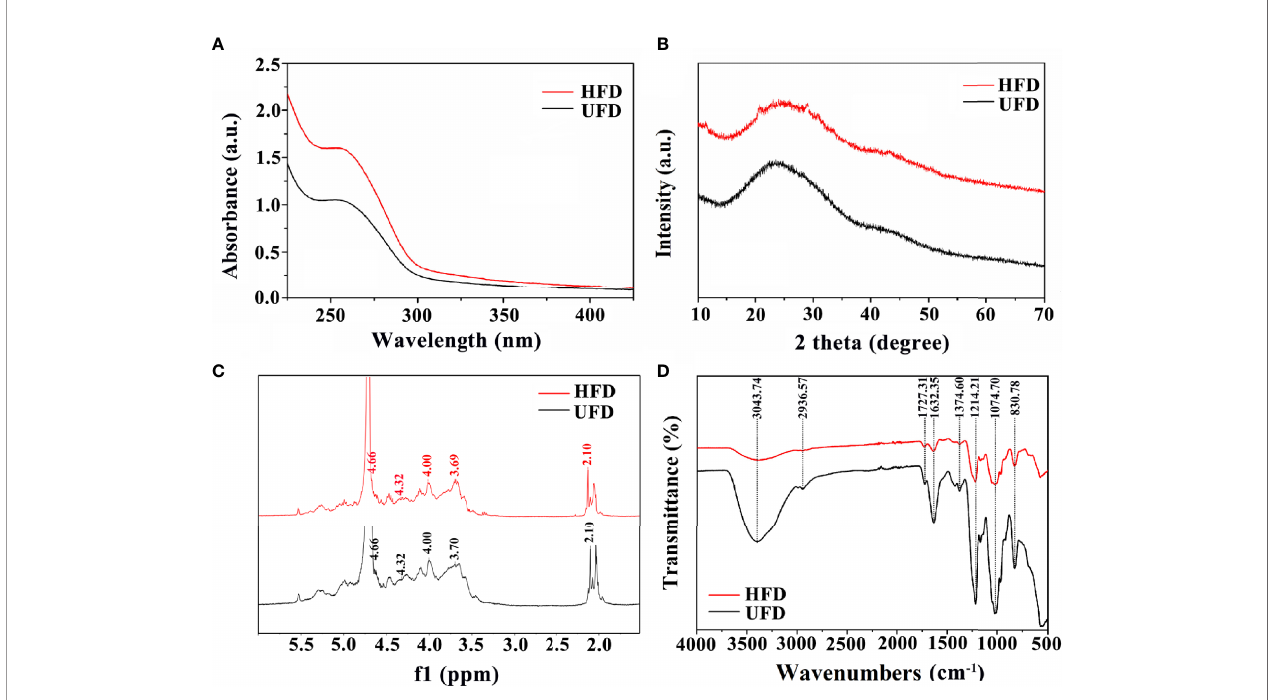
FIGURE 1 | (A) UV-visible spectroscopy, (B) XRD diffraction patterns, (C) 1 HNMR spectrum, and (D) FT-IR spectra of UFD and